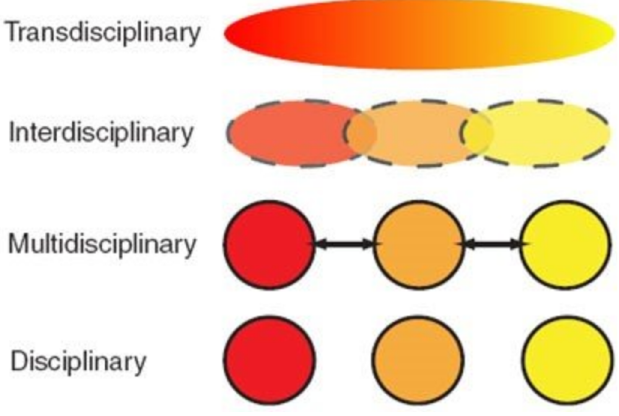
Figure 1. (Philip Mccarty 2016), creative commons https://www.researchgate.net/profile/Philip- Mccarty-2/publication/311486261/figure/fig1/AS:436722644328500@1481134200855/Transdiscipli-